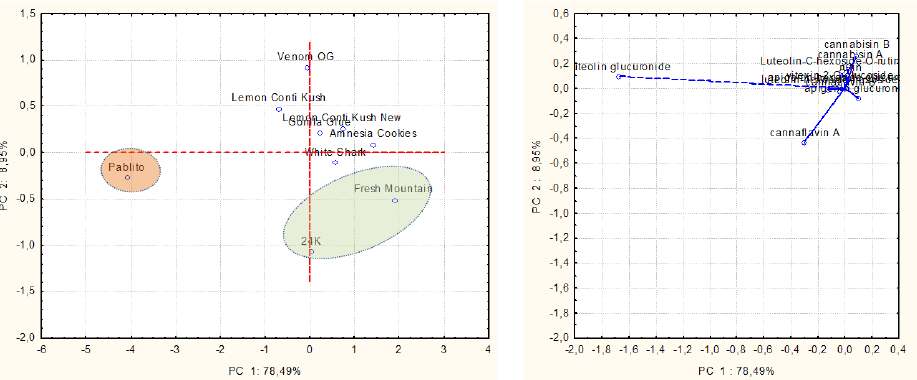
Figure 5. Representation of PCA score and loading plots reporting hemp varieties and their contents of terpenes, polyphenols, and cannabinoids.